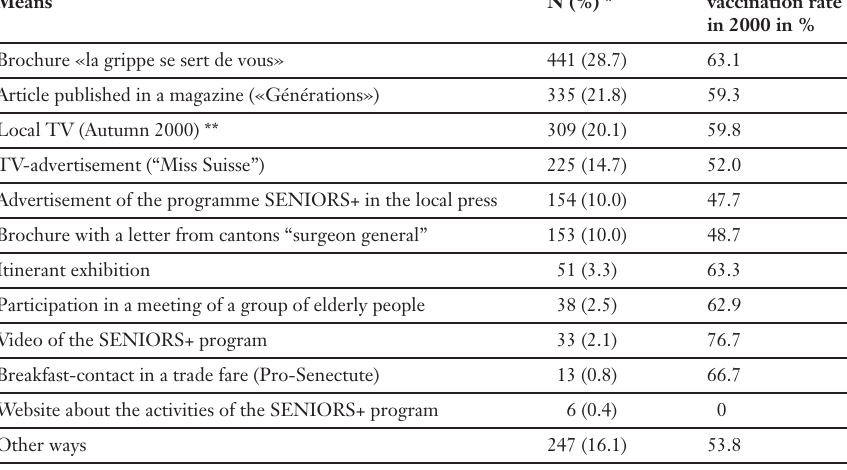
Survey 2001: means by which people had acquired knowledge about the SENIORS+ program, N = 1535.